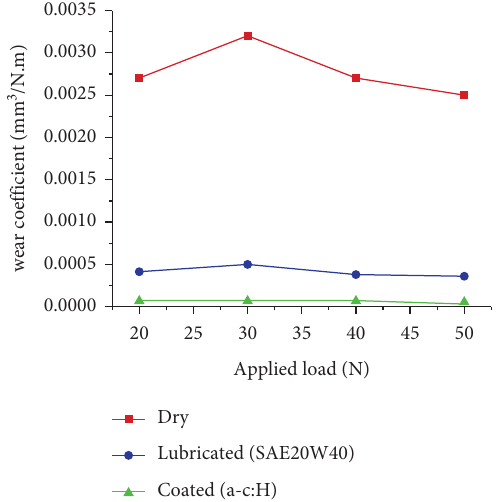
Figure 10: Efect of load vs. wear